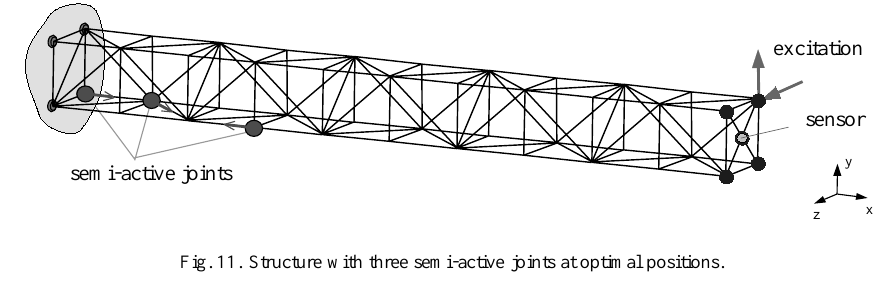
Fig. 11. Structure with three semi-active joints at optimal